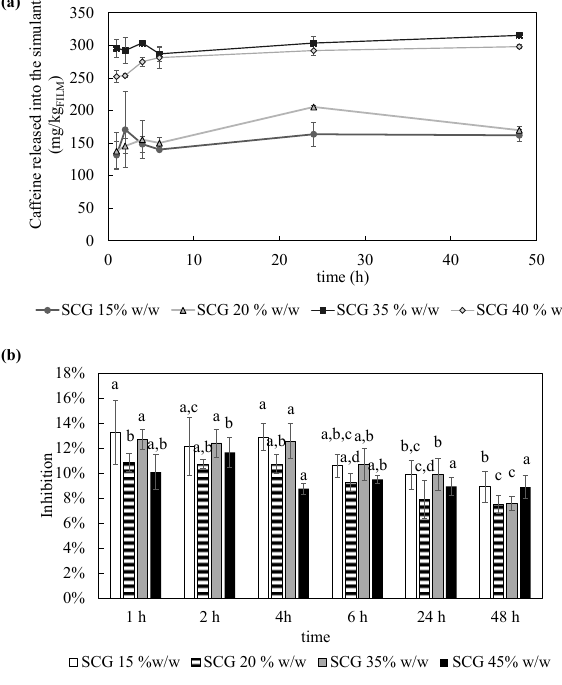
Figure 7. Results of the release tests on films obtained by electrospinning in ethanol 10% ( v / v ), in terms of: ( a ) caffeine released per kg of film, ( b ) radical ABTS • + inhibition. Different symbols indicate statistically significant differences among values over time ( p < 0.05) of dataset with the same extract loading.